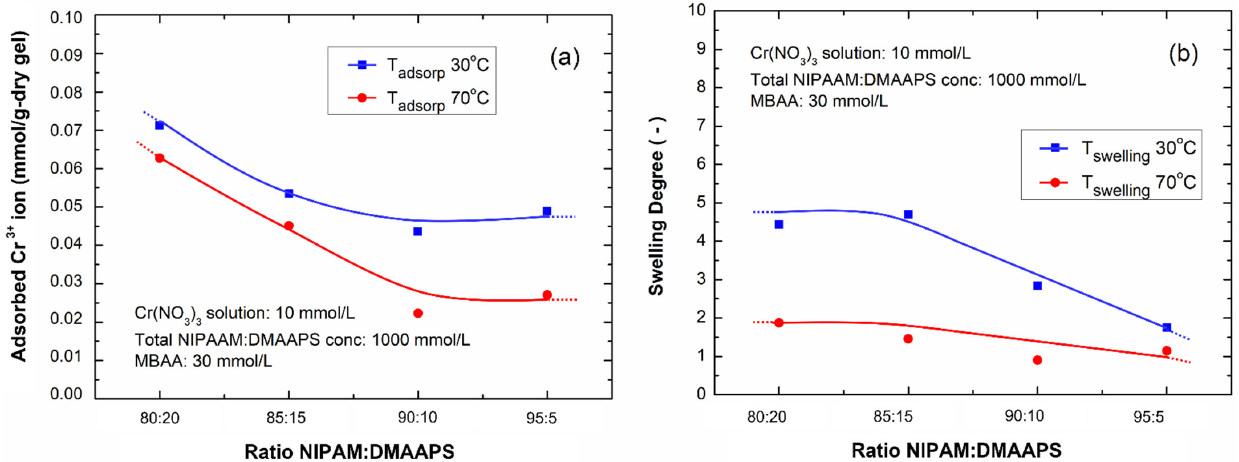
Figure 6. ( a ) Adsorption of Cr 3+ by poly(NIPAAM- co -DMAAPS) gels at different temperatures. ( b ) Swelling degree of poly(NIPAAM- co -DMAAPS) gels at different temperatures.